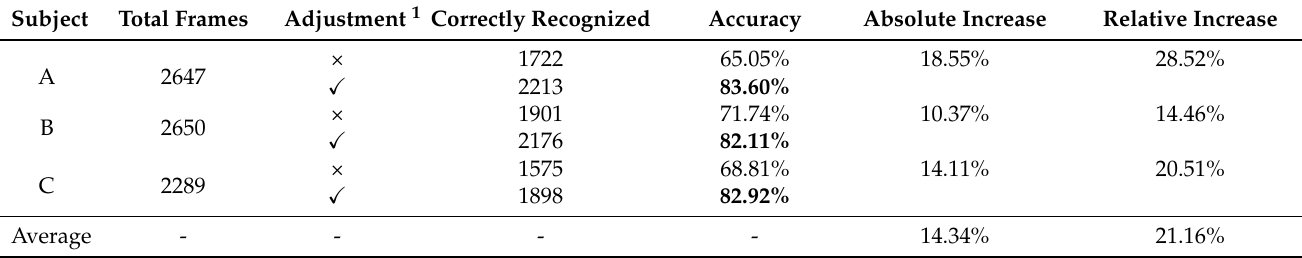
Table 6. Tests of recognition system.